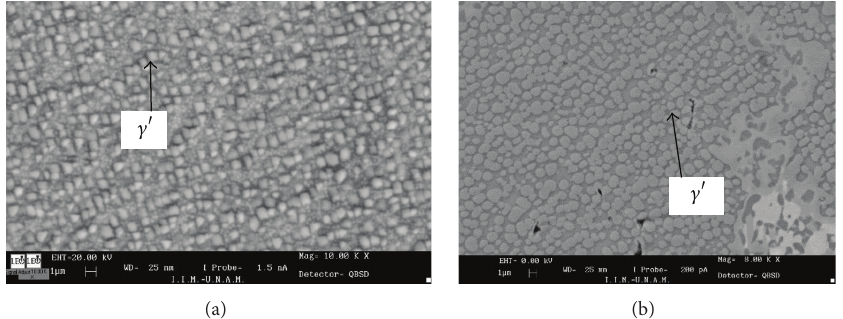
Figure 1: Blade root micrograph of (a) gamma prime ( 𝛾 󸀠 ) without degradation and (b) gamma prime ( 𝛾 󸀠 ) with moderate degradation after 24000 h in service, IN738LC superalloy.